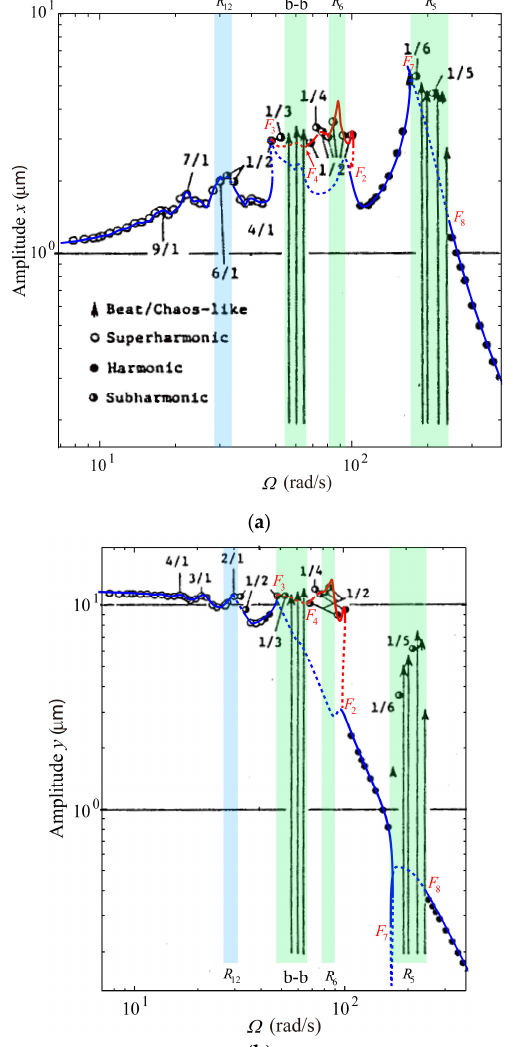
Figure 30. The peak-to-peak frequency–response curves of literature [14], in ( a ) x and ( b ) y directions. Herein, the blue and red lines are the period-1 and period-2 solution branches of Figure 28, respectively, obtained by our